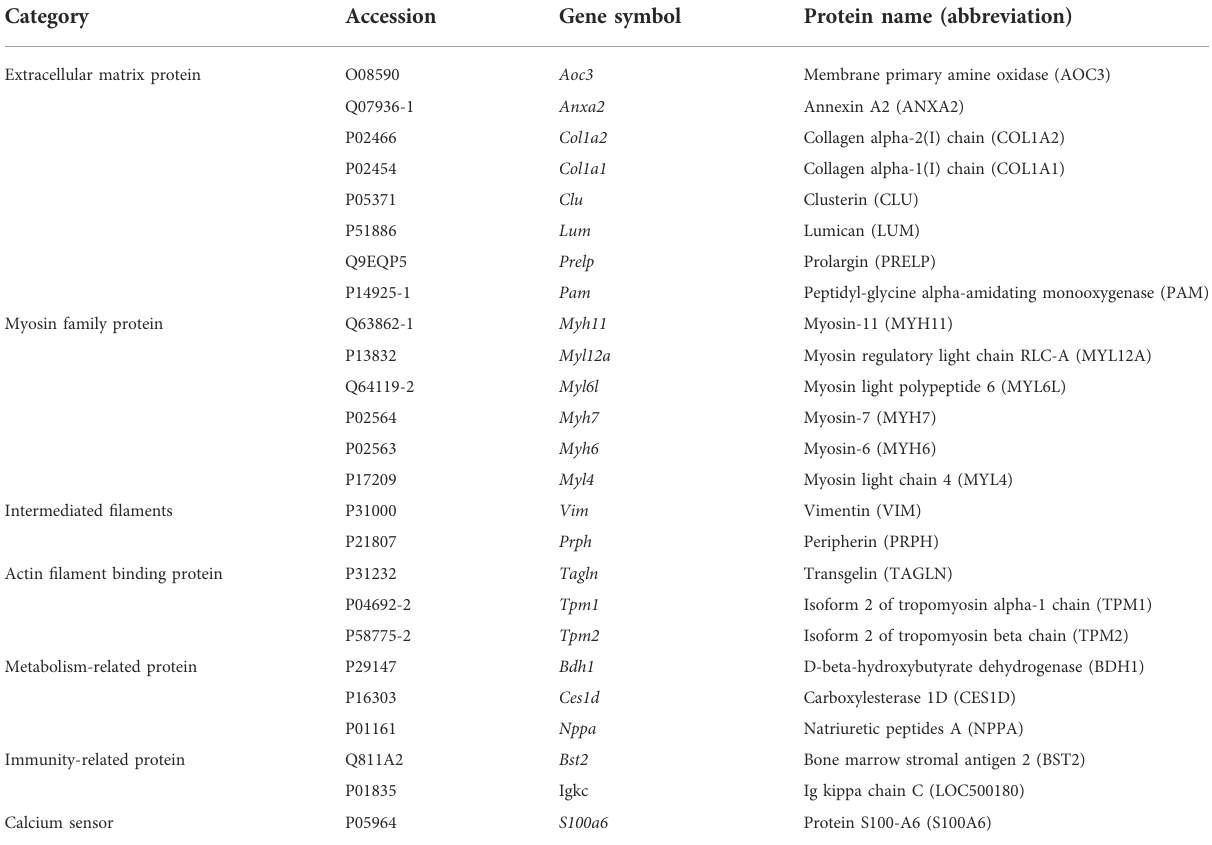
TABLE 3 Differentially expressed proteins in the heart of rats with ISO-iCM.